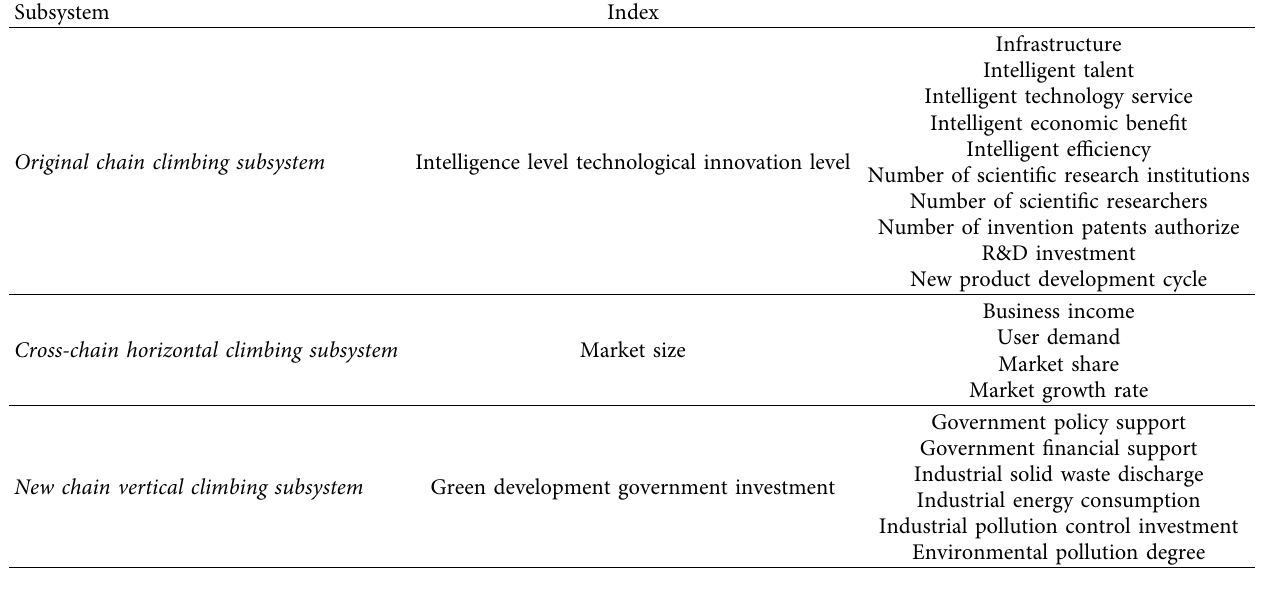
Table 1: Systematic influencing factors of the value chain